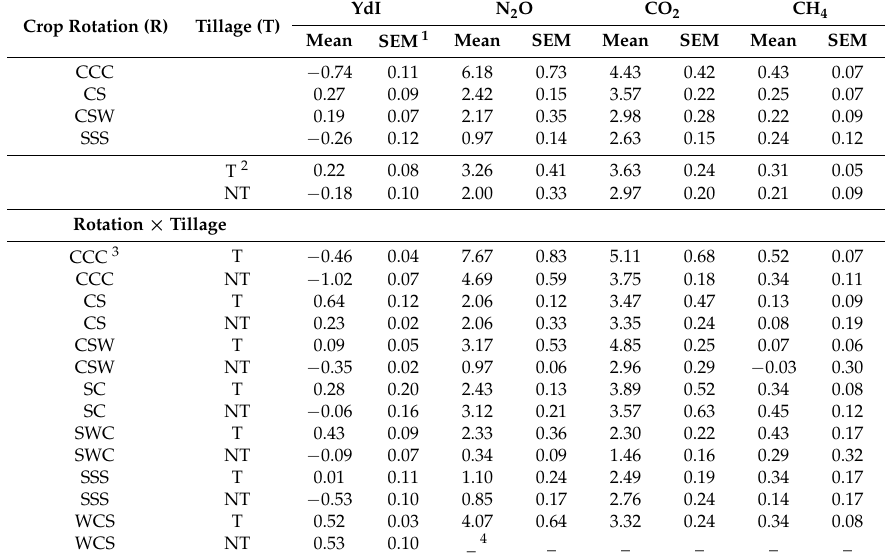
Table A4. Mean values of yield index (YdI), nitrous oxide (N 2 O, kg-N ha − 1 year − 1 ), carbon dioxide (CO 2 , Mg-C ha − 1 year − 1 ), and methane (CH 4 , kg-C ha − 1 year − 1 ), determined by crop rotation (R) and tillage (T) and for each R and T